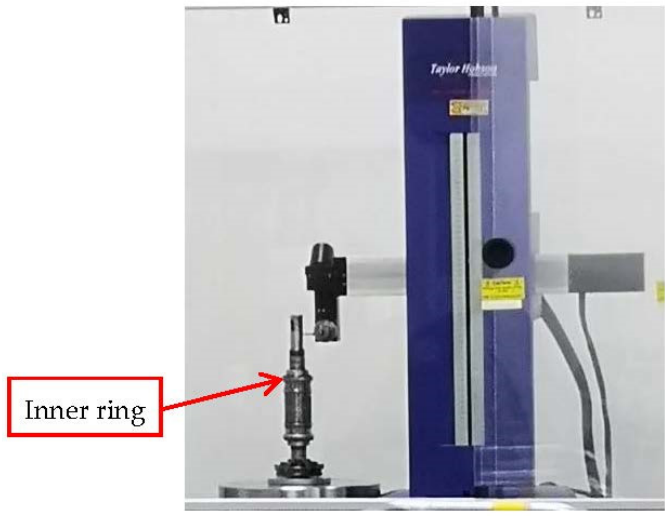
Figure 18. Cylindricity of the inner ring fixed on the shaft is to be measured. Table 6. The cylindricity of the bearing inner raceway under different tightening torque ( µ m). No Tightening Bearing Number Torque